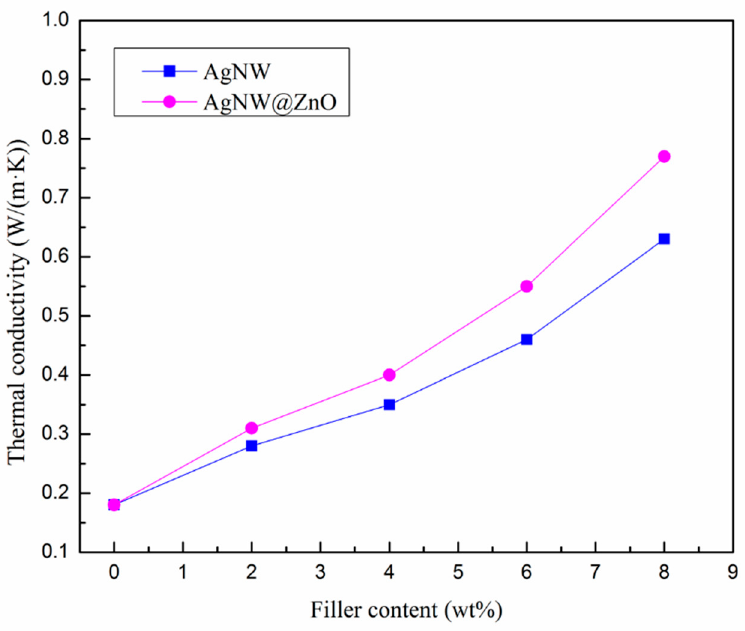
Figure 7. Thermal conductivity of AgNW and AgNW@ZnO-filled epoxy